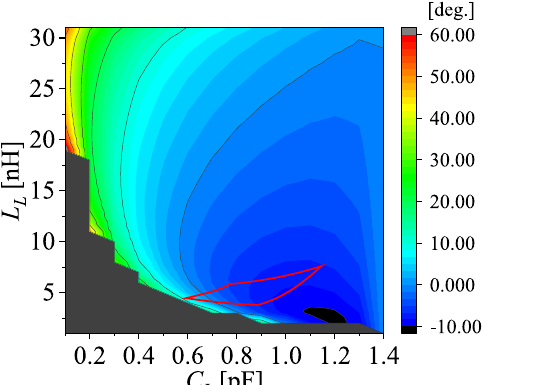
Fig. 8. Bloch impedance Z B at 2GHz depending on C L and L L .